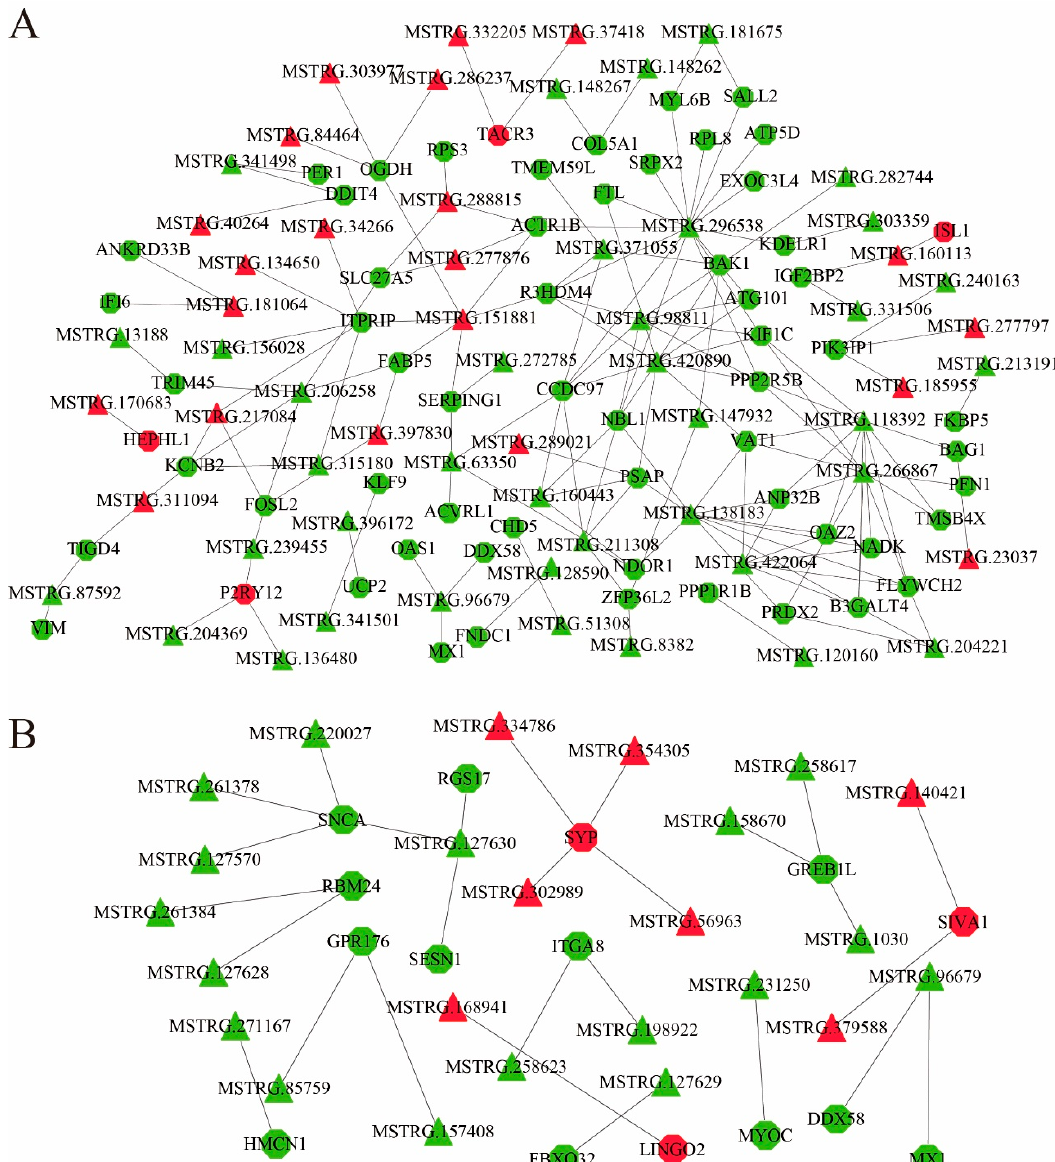
Figure 7. Construction of the lncRNA–mRNA co-expression network. ( A ) Construction of the lncRNA–mRNA co-expression network between the SP and SLP groups. ( B ) Construction of the lncRNA–mRNA co-expression network between the LP and SLP groups. Red and green represent upregulated and downregulated, respectively. Octagons and triangles represent mRNAs and lncRNAs, respectively.